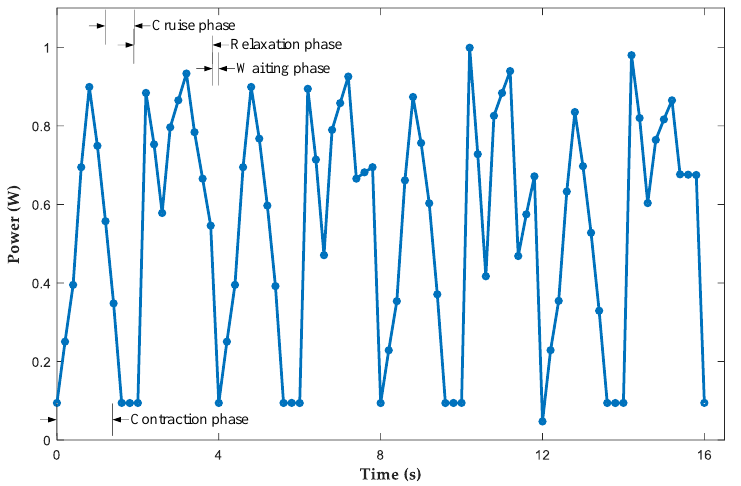
Figure 21. Power variation with time.